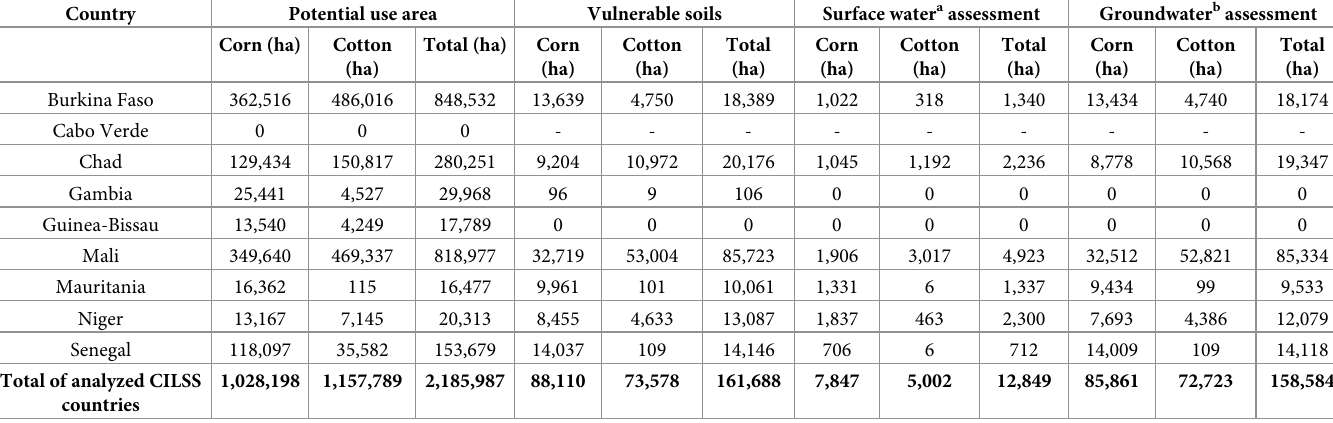
a Surface water assessment used a proximity of 200m instead of 20m. The standard 20m (66ft) buffer would have results in no vulnerable areas in proximity to surface water. b Groundwater assessment assumes shallow groundwater is less than 9m